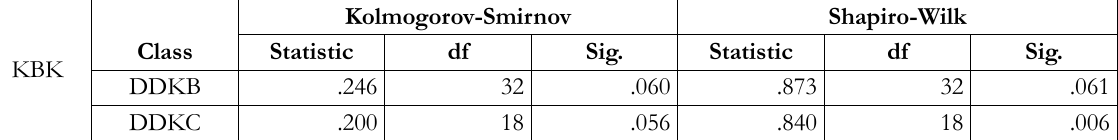
Table 8. Results of data normality test on critical thinking skills of chemistry education